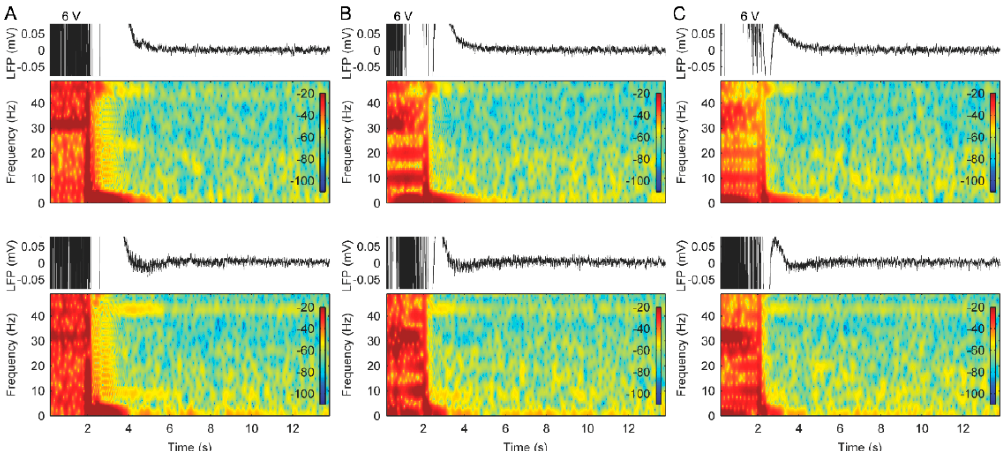
Figure 6. Effects of bilateral stimulation with/without a stimulus ramp on the LFP recordings in the bilateral ACC from patient 3. ( A ) Raw LFP recordings and corresponding spectrograms in the left (top panels) and right ACC (bottom panels) during stimulation without a stimulus ramp. ( B ) Raw LFP recordings and corresponding spectrograms in the left (top panels) and right ACC (bottom panels) during stimulation with a 4 s stimulus ramp. ( C ) Raw LFP recordings and corresponding spectrograms in the left (top panels) and right ACC (bottom panels) during stimulation with an 8 s stimulus ramp. Note that the after-effects observed during 3–6 s were confirmed to be due to sensing channel recovery using the test-tone method.